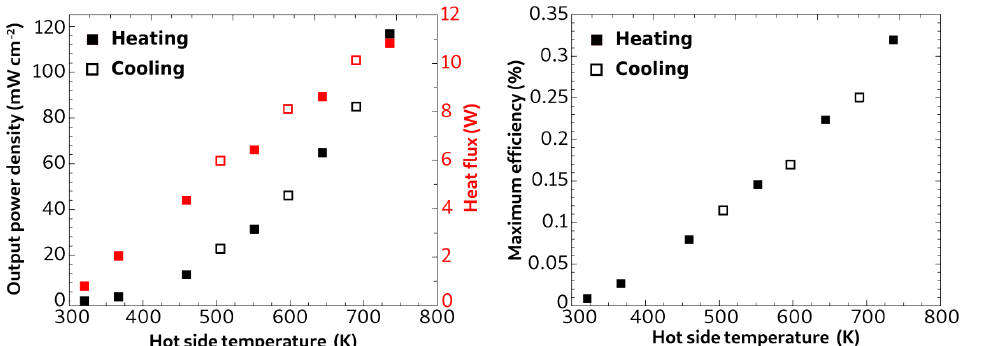
Figure 6. Experimental measurement of ( a ) the output power density P out (black) and the total heat flux Q out (red) and ( b ) the maximum conversion efficiency η measured of the Ti/CrSi 2 /Ti thermo- electric leg. The filled and empty symbols correspond to the heating and cooling steps,